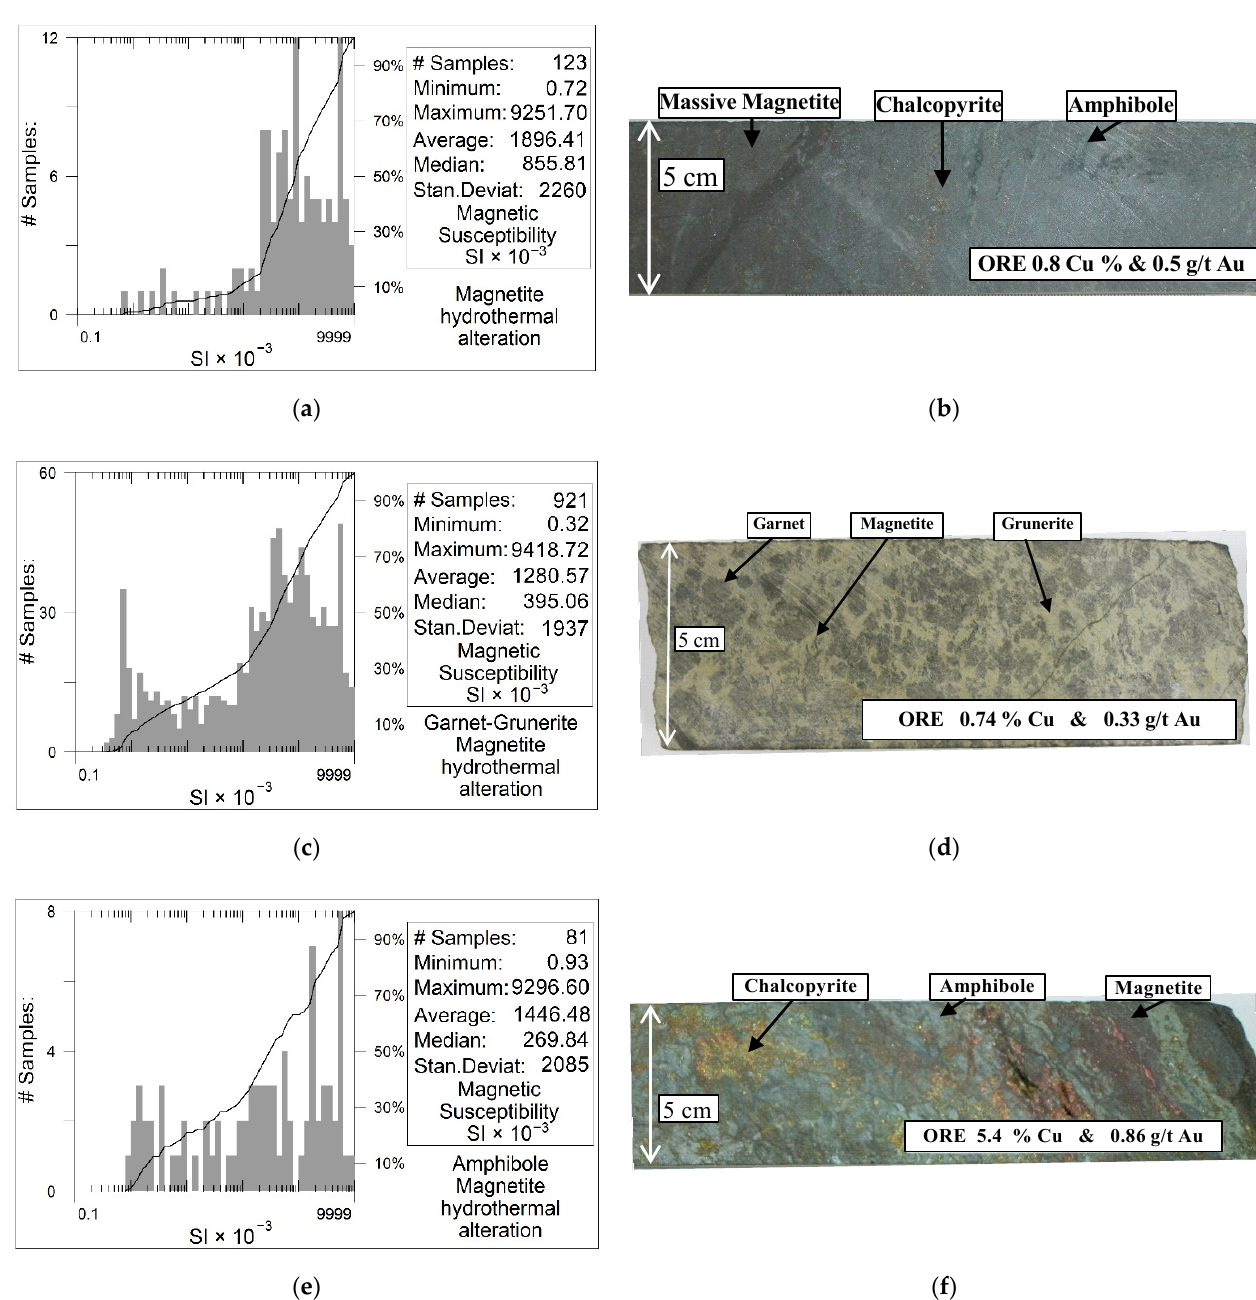
Figure 17. ( a,c,e ) Statistics and histograms of magnetic susceptibility measurements for magnetite rich-alteration types. ( b,d,f ) Core samples pictures of magnetite rich-alteration types. ( a , b ) Massive magnetite (Fe) hydrothermal alteration zone. ( c , d ) Garnet-grunerite-magnetite (Ca-Fe) hydrothermal alteration zone. ( e , f ) Amphibole-magnetite (Na-Ca-Fe) hydrothermal alteration zone.